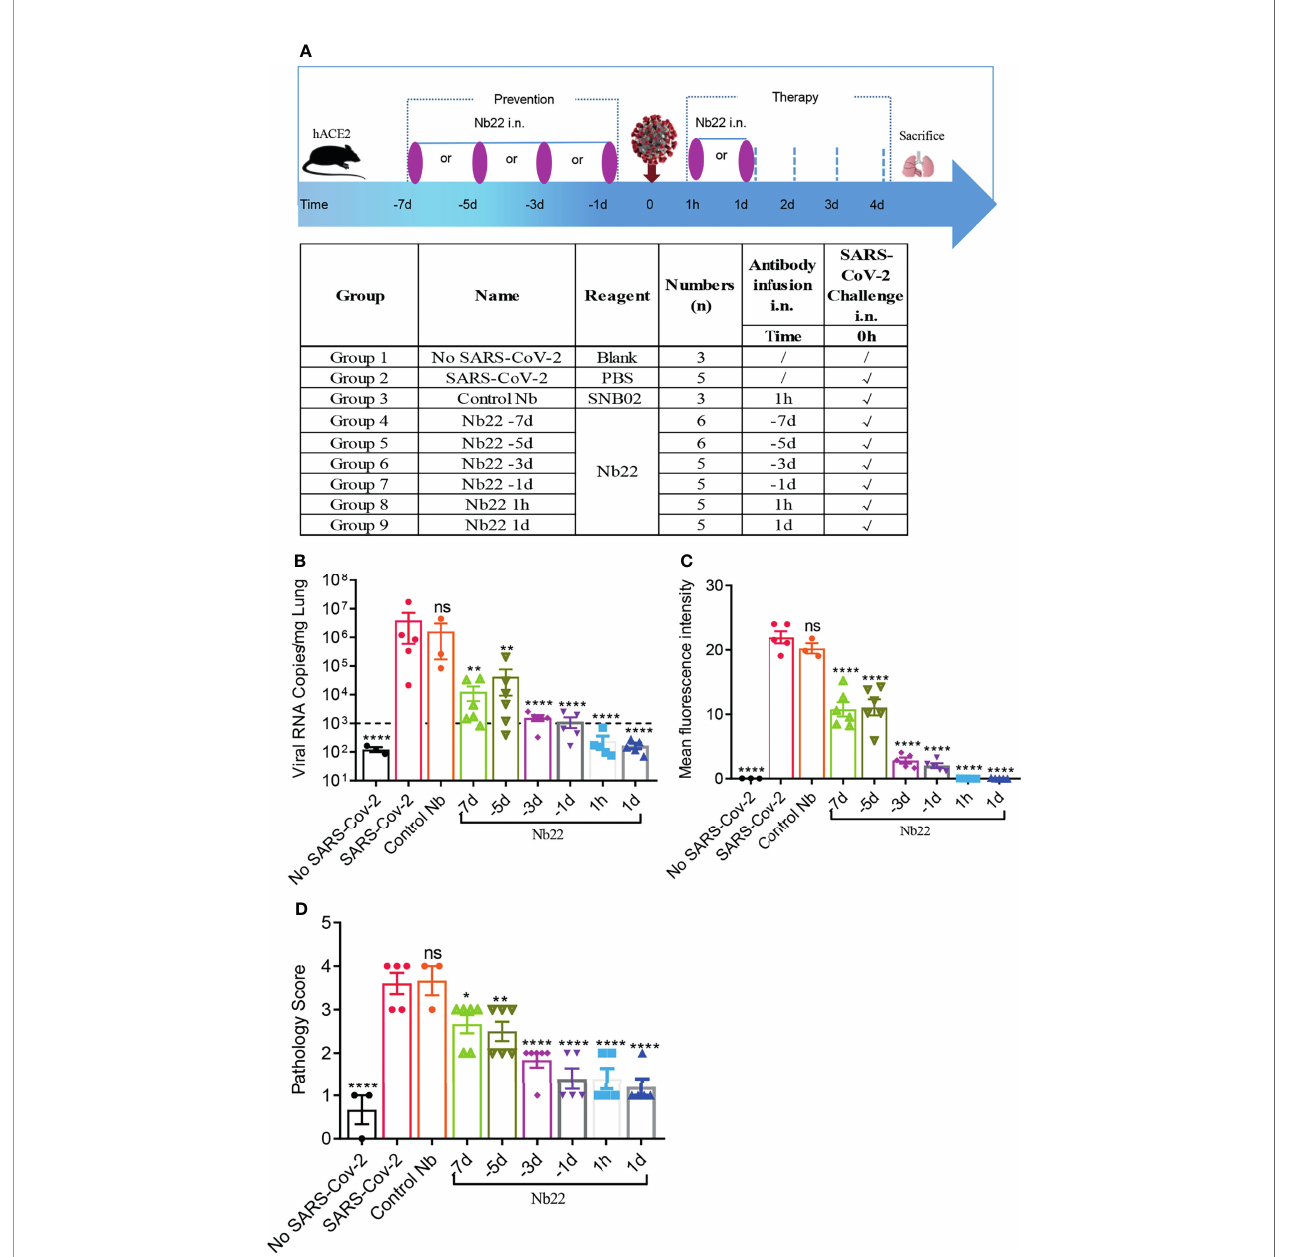
FIGURE 6 | The ef fi cacy of Nb22s evaluated in hACE2 transgenicmice challenged by SARS-CoV-2. (A) Experimental scheduleof Nb22s inthe prevention and treatment of SARS-CoV-2 infection.Bottom,table summaryofgroups (n= 3 – 6 mice) with different treatments. (B) Viral loads inlungs among9 groups were measured by qRT-PCR.The name of each group inthe x axiswas indicated as inthe table inpanel (A) . Each dot represents one mouse. The limit of detection was 1,000 copies/mg referenced to blank control (No-SARS-CoV-2 group).Data are represented as mean ± SEM;Mann – Whitney testwas performedto compare treatment group with the SARS-CoV-2 control group. (C) Sections of lung were analyzed byimmuno fl uorescence staining using antibodies speci fi c to SARS-CoV-2 NP in redand DAPIfor nuclei in blue, respectively. The fl uorescence signal intensity ofred was taken as a quantitative indicator for viralinfection, which was calculated byImageJ software. (D) Sections of lung were analyzed by H&Estaining, which were scored for pathological severity of disease ona scaleof 0 to 5 grades according to the alveoliintegrity and the in fl ammatoryfactors invasion. ns, no signi fi cance; *p<0.05, **p <0.01, ****P < 0.0001. All experiments of panels (B, C) were repeated